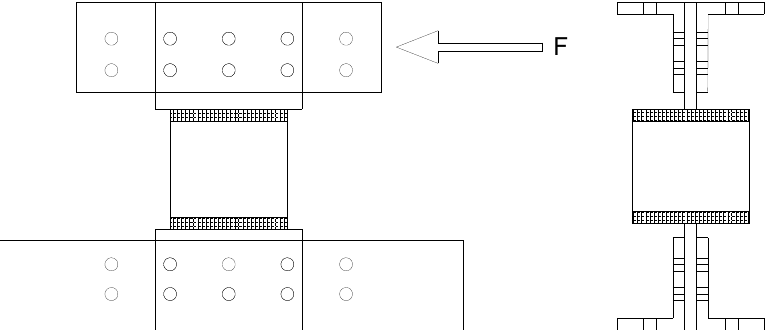
Figure 2. Structure of shear square section steel tube damper (L × H × B was 200 mm × 200 mm × 200